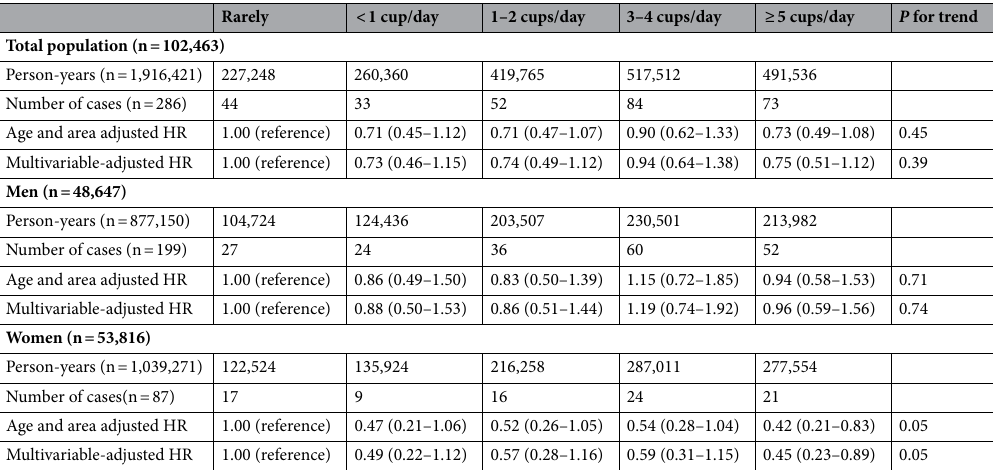
North America 16 . And the summary RR of other regions was 0.93 (95% CI: 0.72–1.21), indicating the difference between geographical regions 16 . Our results were consistent with results from another cohort study in Japan, the Japan Collaborative Cohort Study (JACC study) 49 , which was included in the meta-analysis by Rhee et al. The JACC study reported an age-and sex-adjusted HR of 2.69 (95% CI: 0.89–8.10) among participants who drank more than three cups of coffee per day, compared with participants with no coffee intake 49 . The heterogeneity in results among different studies included in the meta-analysis on coffee may be ascribable to methodological